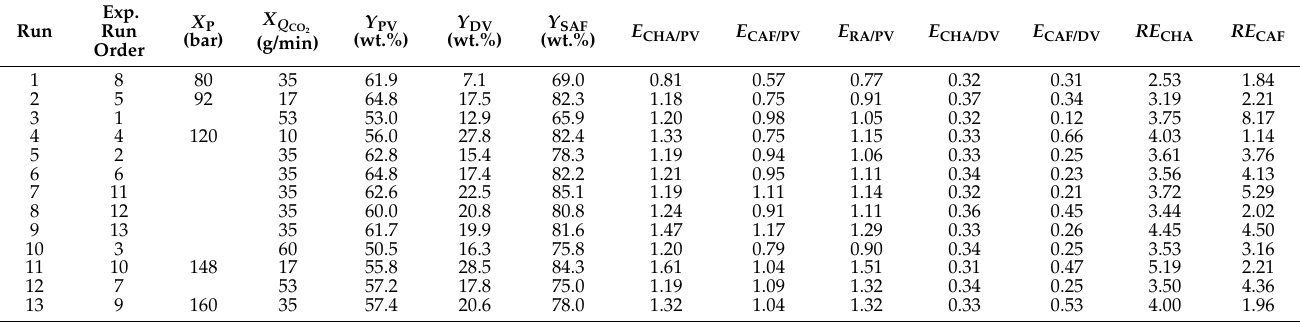
Table 1. Operational conditions of pressure, X P , and CO 2 flow rate X Q SAF process applied to the ethanolic extract from defatted S. officinalis leaves along with the corresponding results for the yields and enrichment ratios as defined by Equations (3)–(7). Exp.